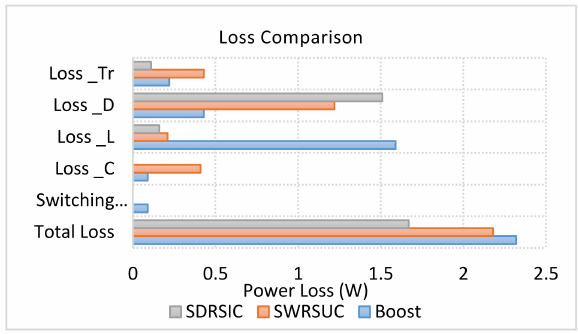
Figure 14. Loss Comparison among different